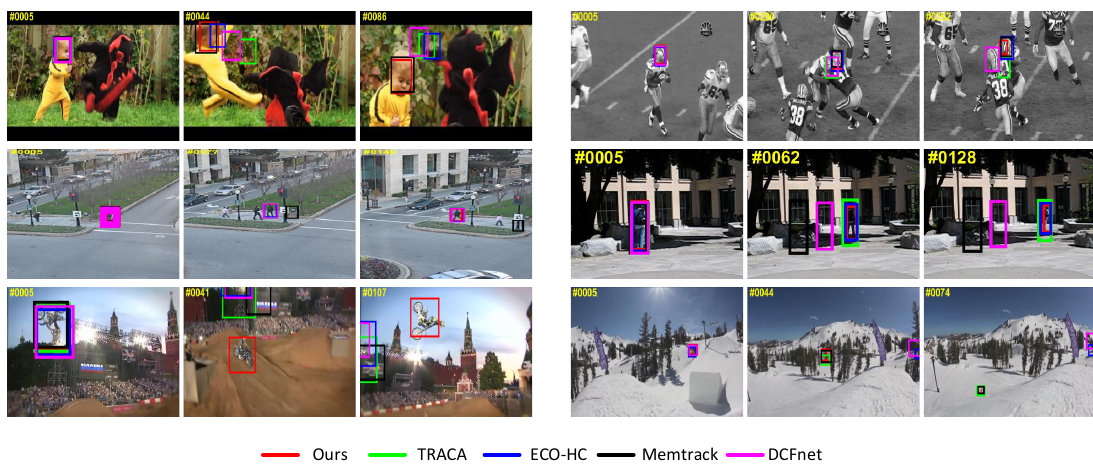
Figure 6. Qualitative tracking results of our tracker, TRACA, ECO-HC, Memtrack, and DCFnet on six challenging sequences. From left to right and top to bottom are Dragonbaby, Football, Human3, Human8, Motorrolling, and Sking, respectively.